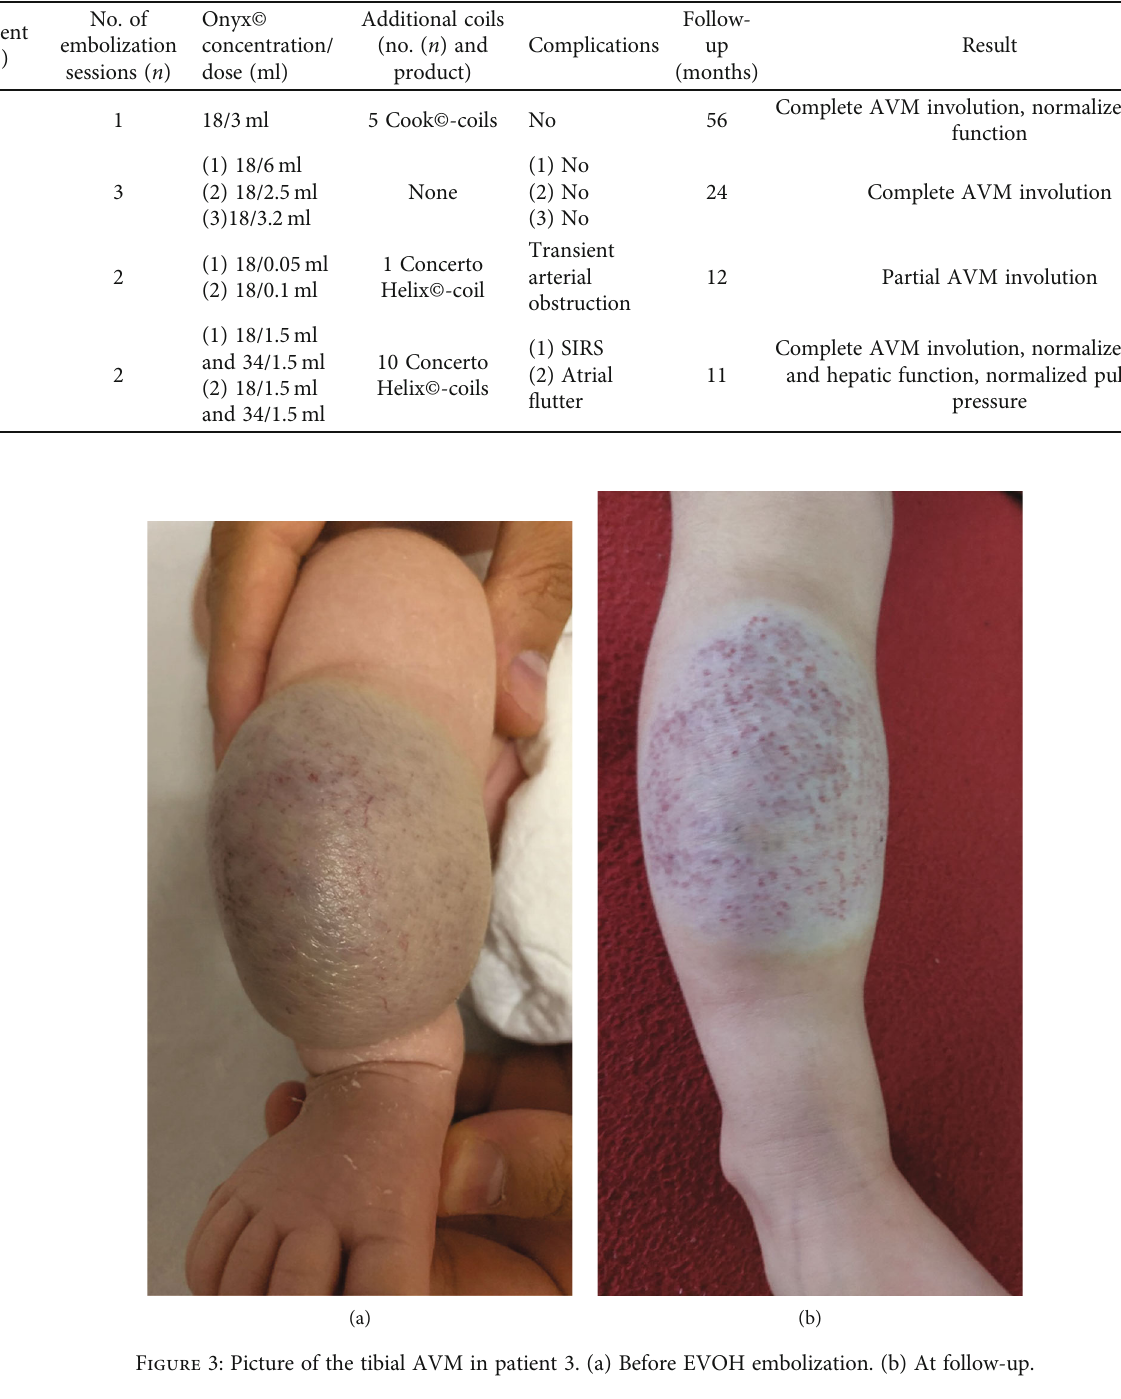
Table 2: Embolization method and results.